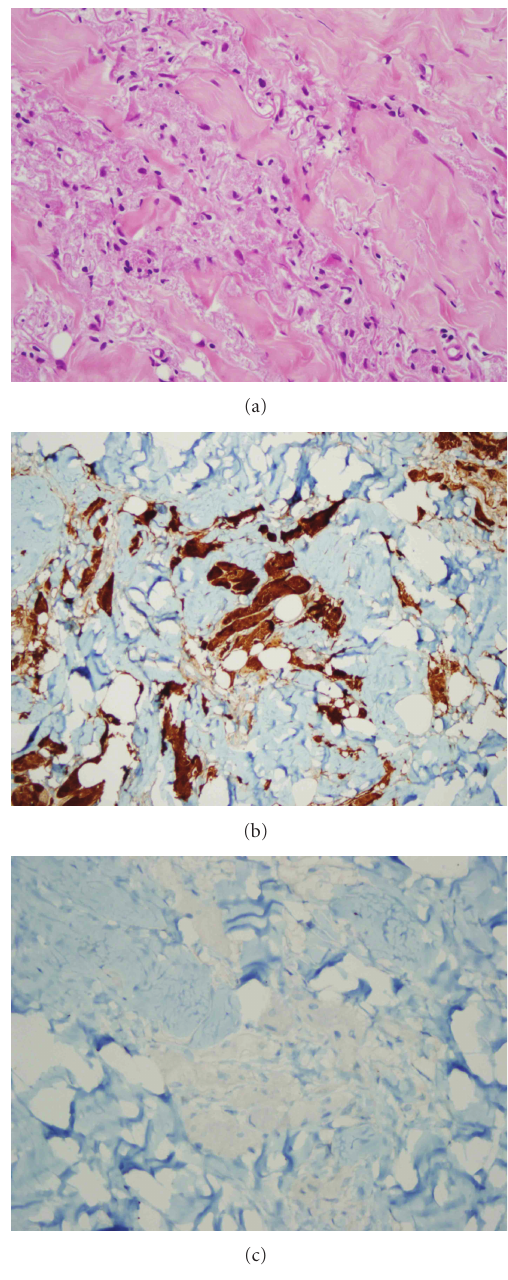
Figure 3: Pathological microscopic examination demonstrates the infiltration of cells with eosinophilic granular cytoplasm (a); (hematoxylin eosin, × 400), immunohistochemical staining positive for S100 protein (b); ( × 200), and negative for cytokeratin (c); ( ×